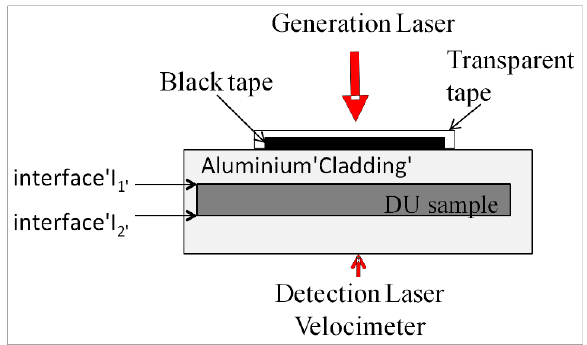
Figure 1. The plate fuel specimen, geometries, plasma constraining mechanism and back surface velocity detection for laser shock testing is shown.